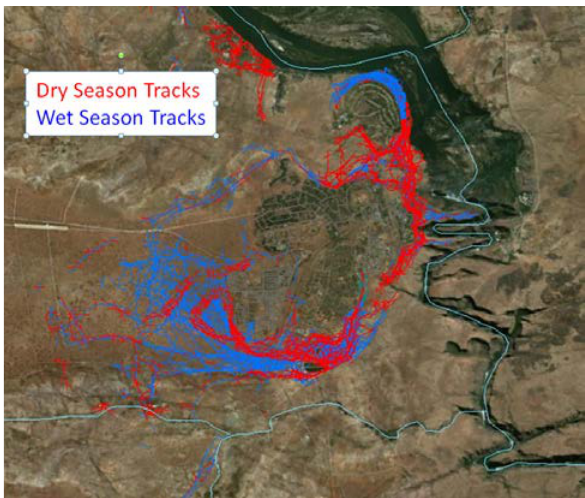
Figure 7. Animated 2D visualizations of bull elephant movements in and around Victoria Falls are color-coded by wet (blue) and dry (red) seasons. The tracks depict differences in locations and dispersion patterns related to habitat condition, food and water availability and the growth of agricultural crops.